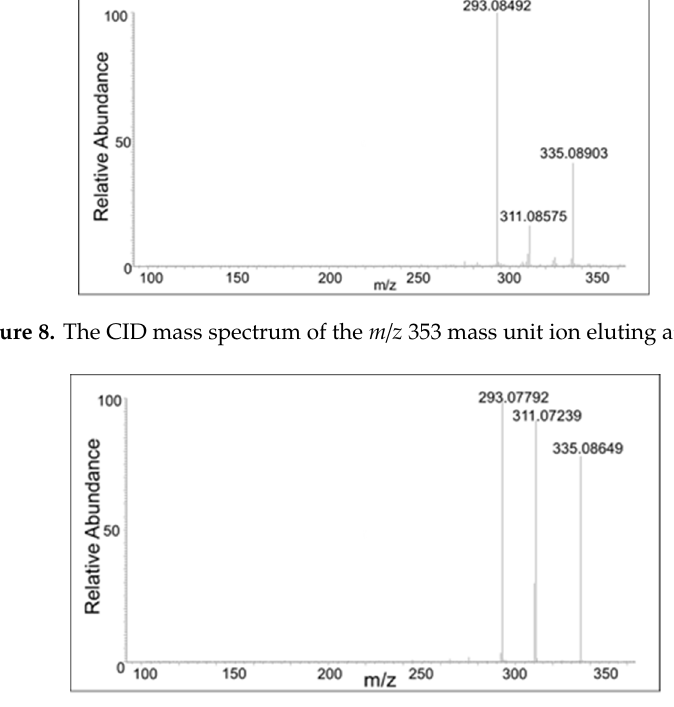
Figure 9. The CID mass spectrum of the m / z 353 mass unit ion eluting at 18 min.